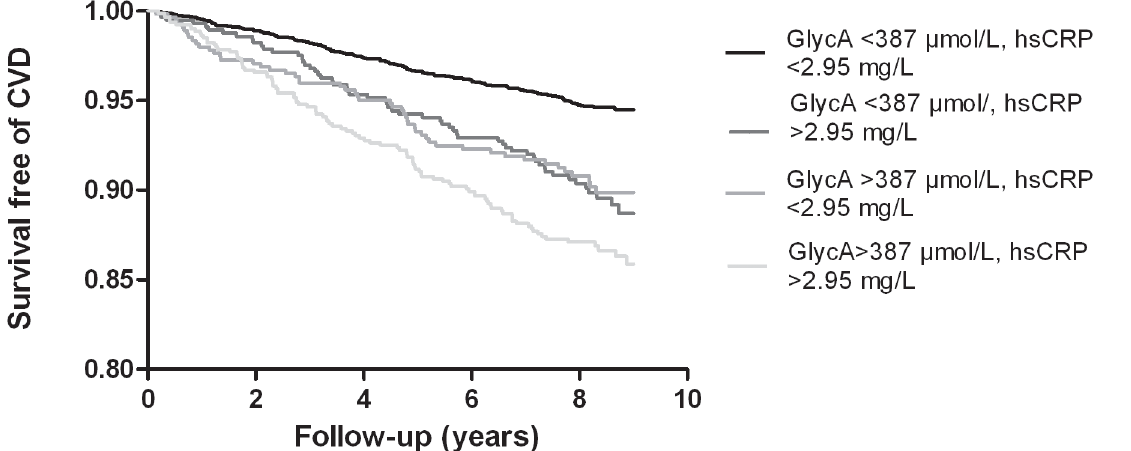
Fig 3. Kaplan-Meier curves of incident cardiovascular events according to joint levels of higher GlycA and hsCRP, P (cid:3) 0.001 by log-rank test. Higher levels of GlycA and hsCRP were defined as > 387 μ mol/L for GlycA and > 2.95 mg/L for hsCR in both sexes combined. hsCRP , high sensitivity C- reactive protein.